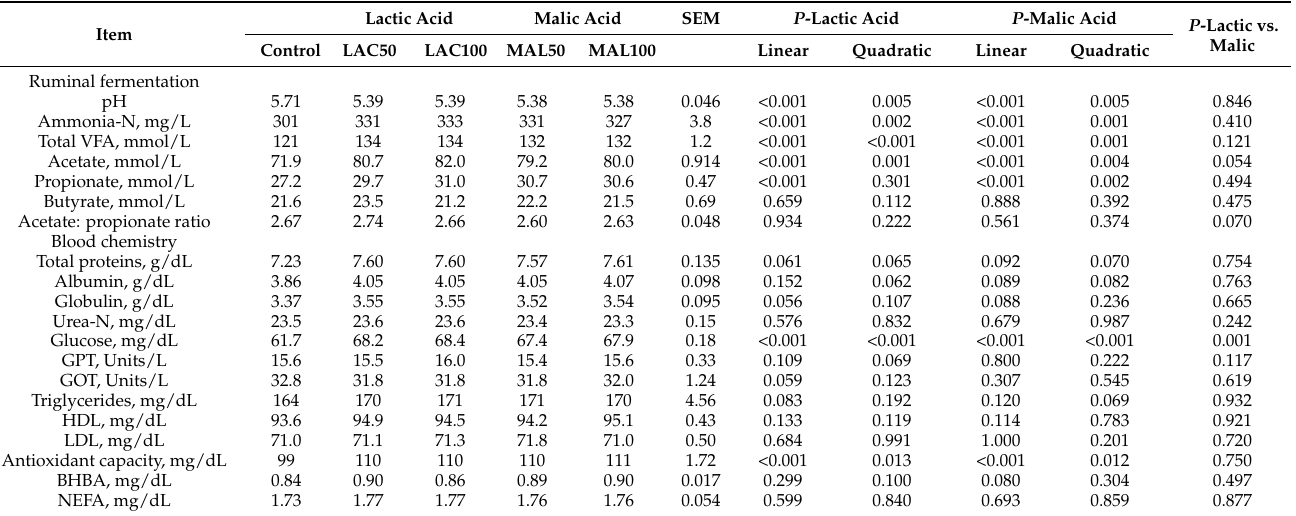
Table 3. Ruminal fermentation and blood measurements of lactating Farafra ewes fed a diet contain- ing date palm leaves ensiled without additives or ensiled with lactic acid or malic acid 1